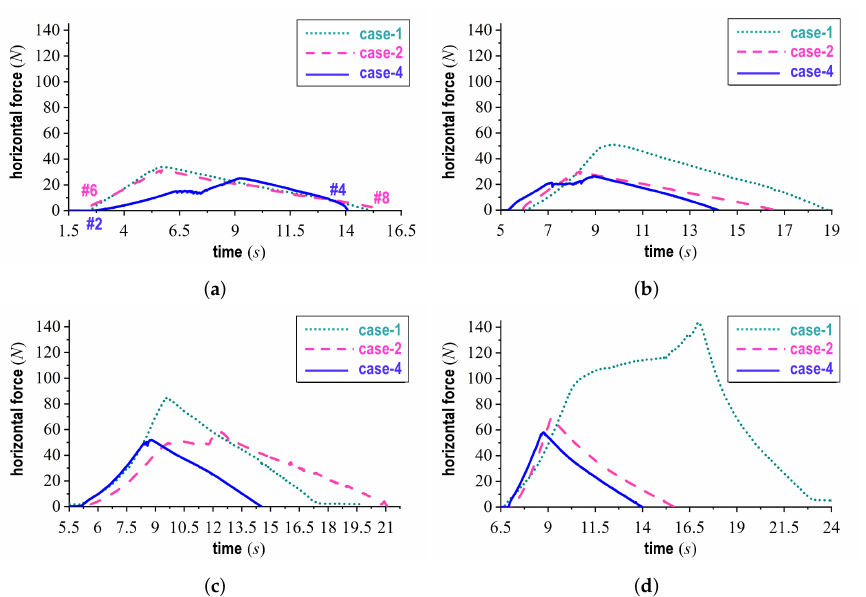
Figure 18. Comparison results for required horizontal forces during step ascending where case-1, case-2, and case-4 denote a conventional wheel, a wheel with vertically translated axle, and the proposed wheel, respectively. Moreover, the frame numbers under the case of 20 mm mean a specific motion scene in Figures 16 and 17a, respectively. ( a ) Step height of 20 mm; ( b ) step height of 30 mm; ( c ) step height of 40 mm; ( d ) step height of 50